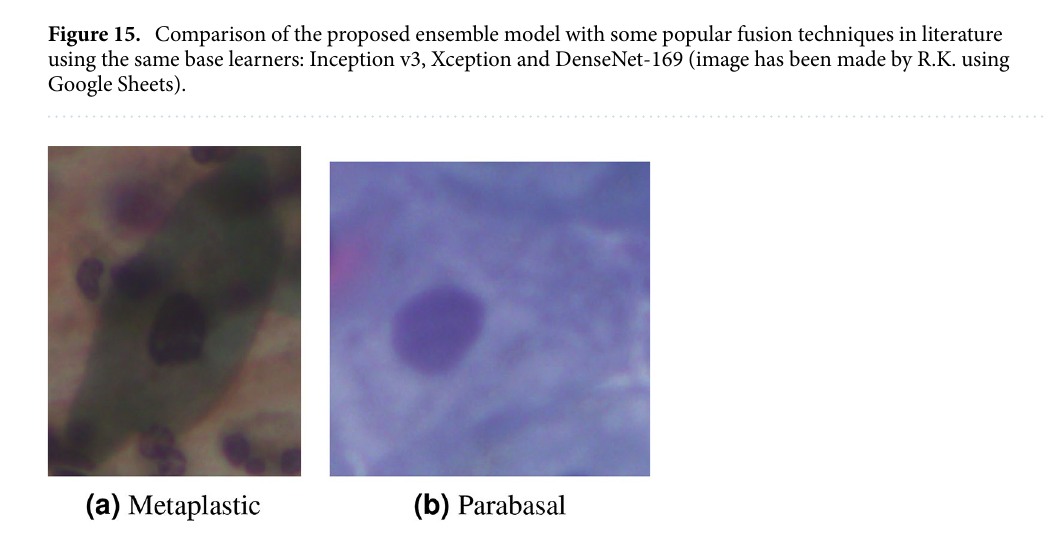
Figure 16. Examples of test samples from the SIPaKMeD Pap Smear dataset 9 where one or more of the base classifiers predict incorrectly, but the ensemble predicts correctly. (a) DenseNet-169 classifies the sample as: “Koilocytotic” with confidence 31%, Xception classifies the sample as: “Parabasal” with confidence 36% and Inception v3 classifies the sample as: “Metaplastic” with confidence 98%. Ensemble prediction is: “Metaplastic”. (b) DenseNet-169 classifies the sample as: “Koilocytotic” with confidence 32%, Xception classifies the sample as “Parabasal” with confidence 95%, and Inception v3 classifies the sample as “Parabasal” with confidence 98%. Ensemble prediction is: